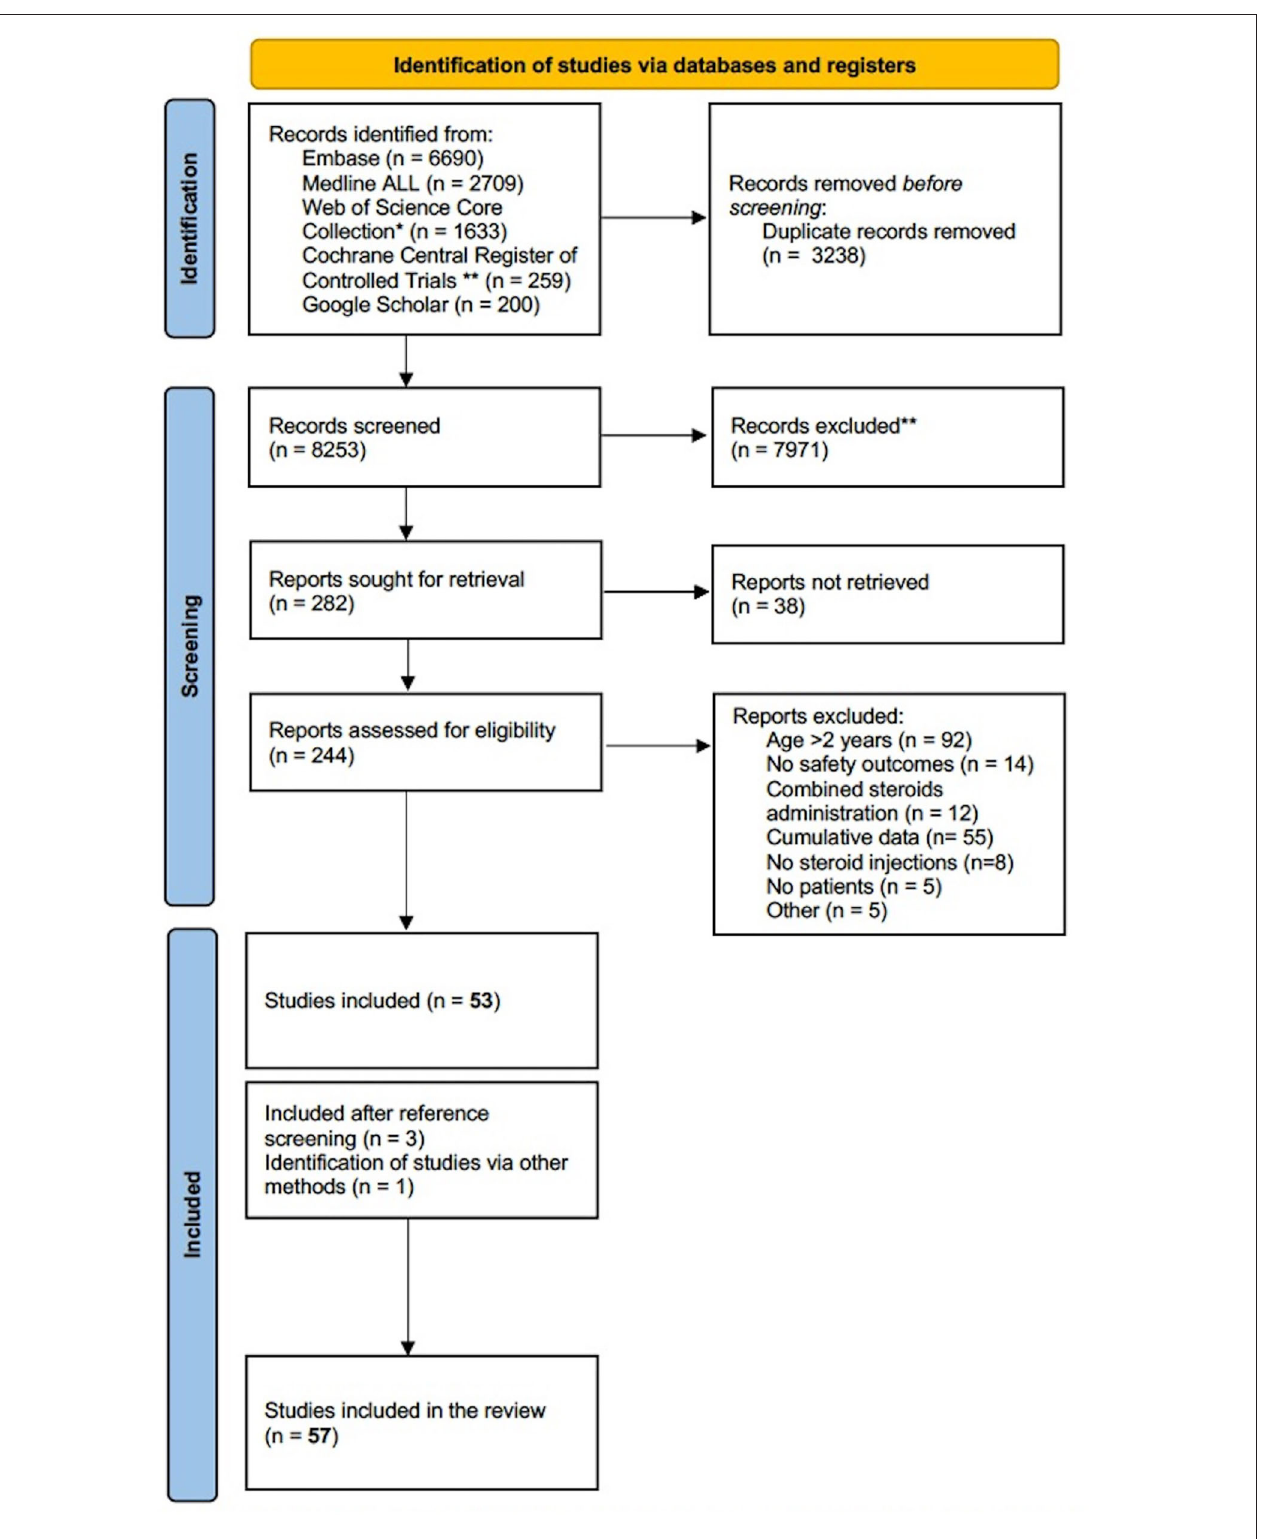
FIGURE 1 | PRISMA flow diagram of literature search (15). *Science Citation Index Expanded (1975-present); Social Science Citation Index (1975-present); Arts and Humanities Citation Index (1975-present); Conference Proceedings Citation Index-Science (1990-present); Conference Proceedings Citation Index- Social Science and Humanities(1990-present); Emerging Sources Citation Index (2015-present). **Manually deleted abstracts from trial registries.